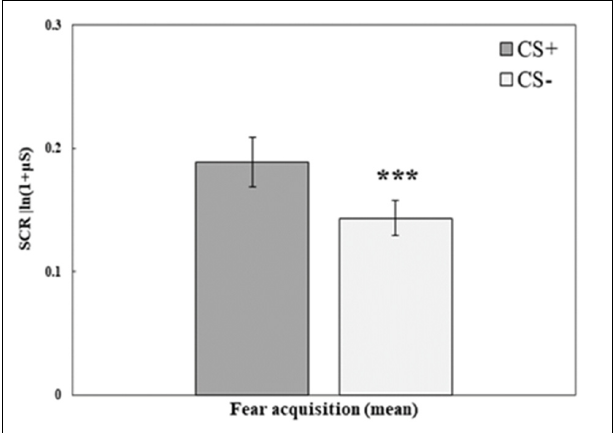
FIGURE 2 | Day 1: Fear acquisition training. Mean ( ± SEM) SCR to the three conditioned stimuli (mean of 10 trials for CS+ and CS − ). SCR to the reinforced CS+ are significantly higher (RE+CORT: 0.16 ± 0.03; RE: 0.17 ± 0.03; CORT: 0.24 ± 0.04) than the SCR to the unreinforced CS − (RE+CORT: 0.10 ± 0.02; RE: 0.14 ± 0.02; CORT: 0.18 ± 0.03; ∗∗∗ p < 0.001), demonstrating successful fear learning. The figure presents all three groups combined ( N = 75; RE+CORT group: n = 25, RE group: n = 25, CORT group: n = 25) as no interaction and no main effect of group were